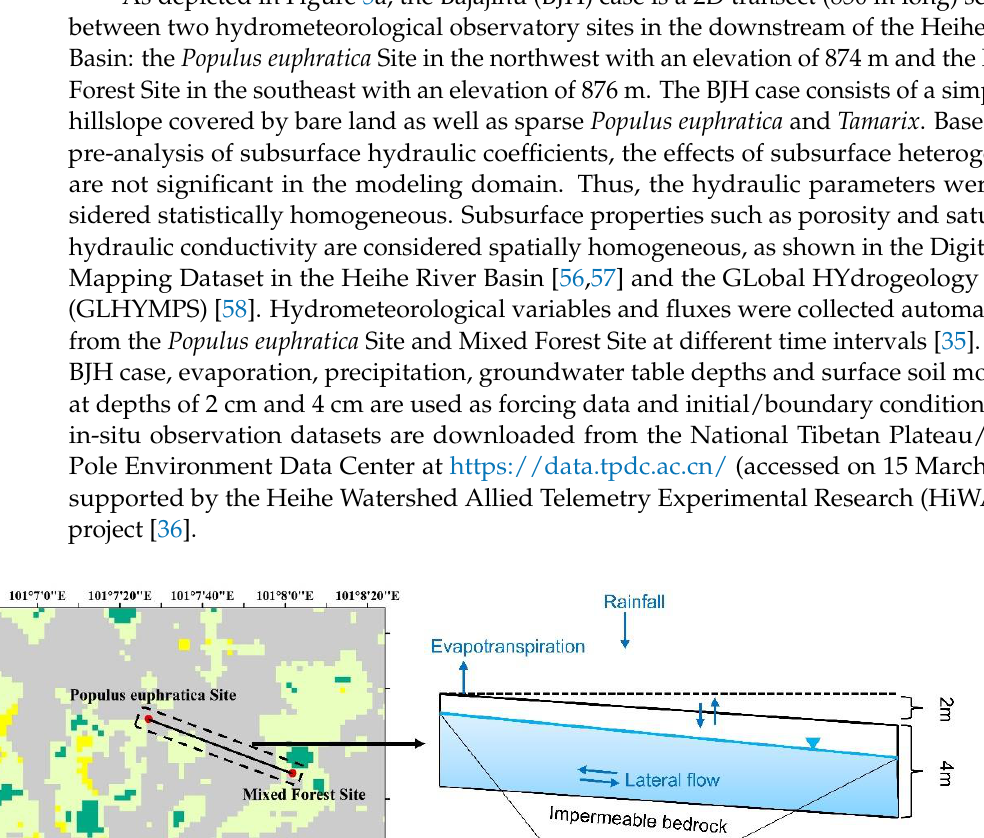
Figure 4. Computational domains of the 2D sandbox: ( a ) Schematic description of the sandbox; ( b ) 2D view of the sandbox.